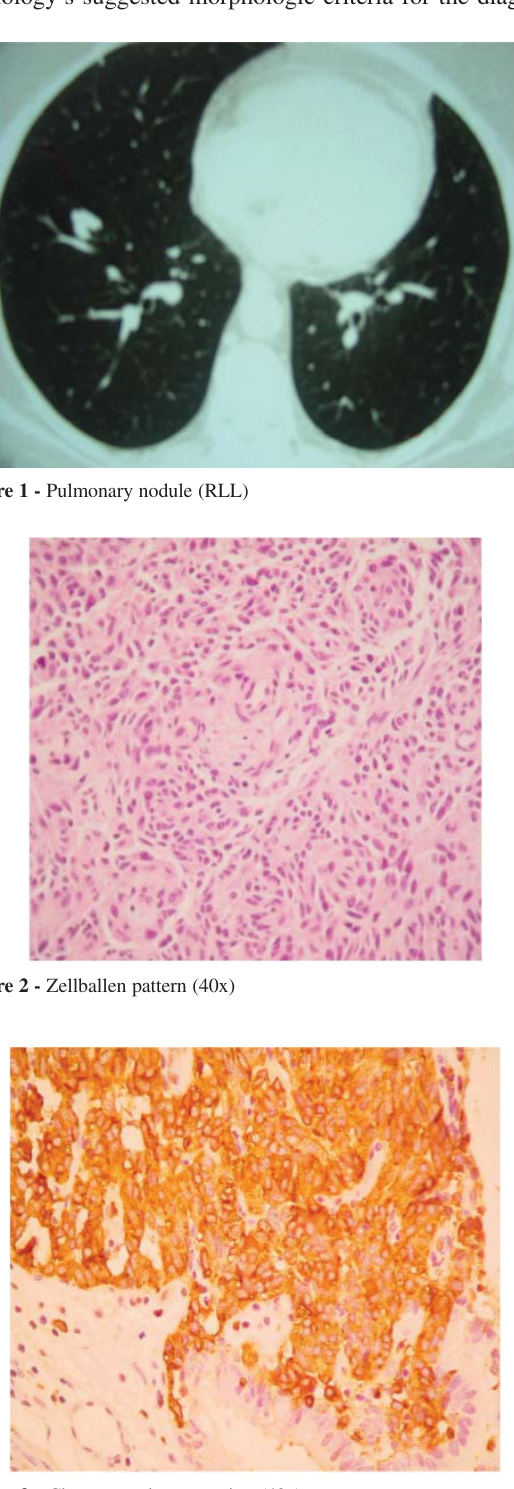
Figure 3 - Chromogranin expression (40x) Figure 6 - S 100 protein expression (40x)